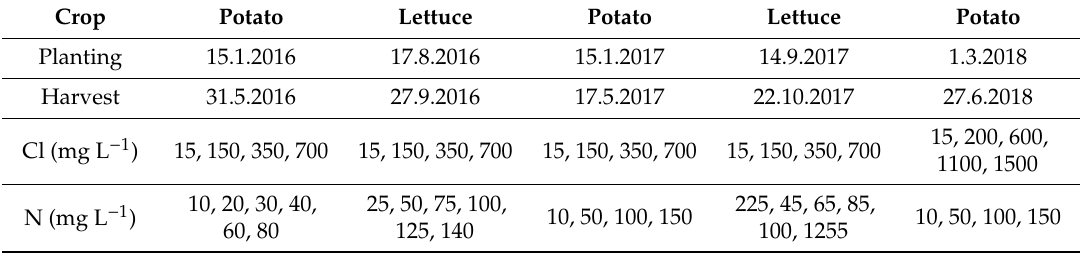
Table 1. List of the Lettuce and potato experiments conducted in the lysimeters, Bet Dagan, 2016–2018. Crop Potato Lettuce Potato Lettuce Potato